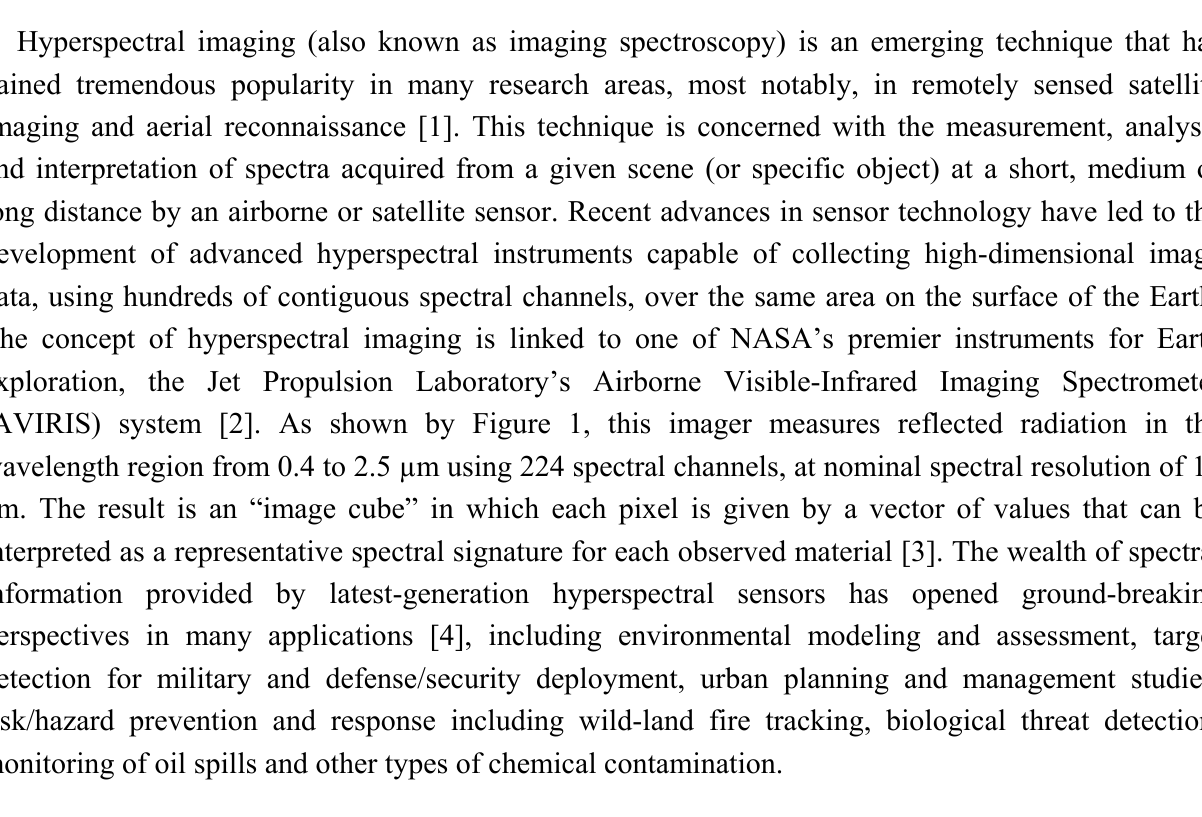
Figure 1. The concept of hyperspectral imaging illustrated using NASA’s AVIRIS